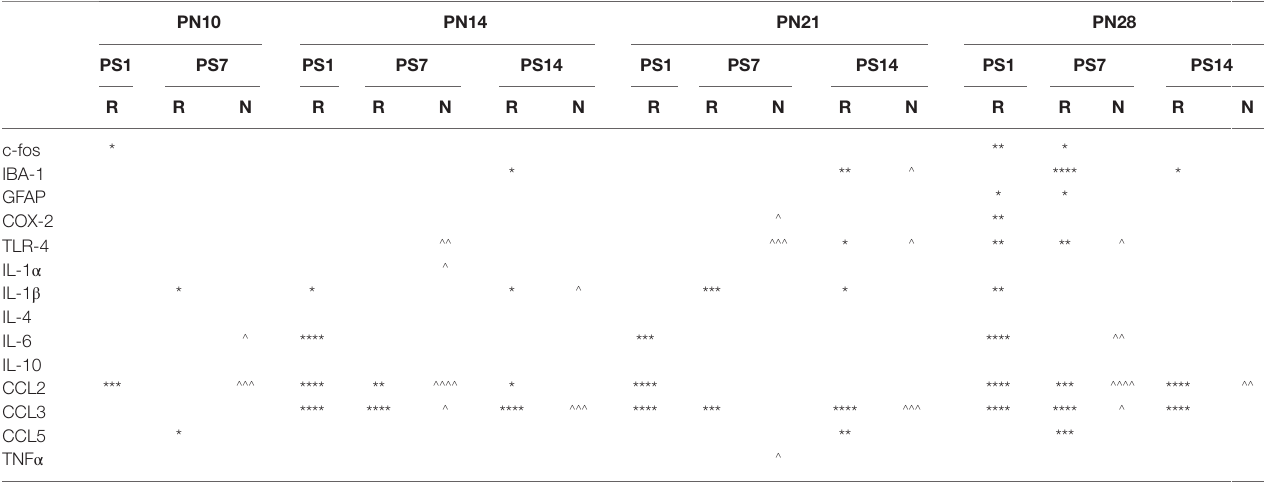
Table 4 | summary of qPcr